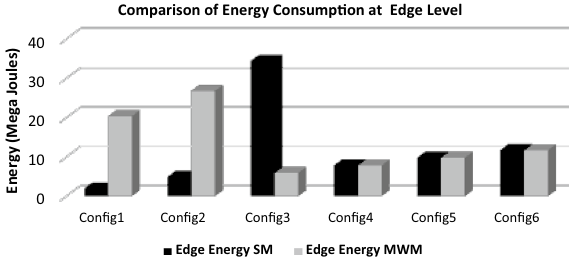
Fig. 8 The average energy consumption on the sequential and master-worker modules